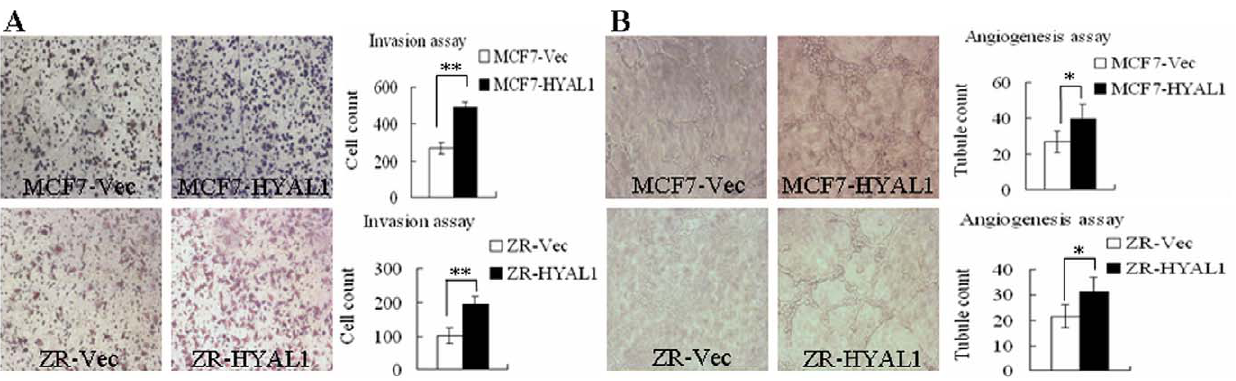
Figure 6. Upregulation of HYAL1 in breast cancer cells promoted cell invasion and angiogenic capability in vitro. Invasion assays (A) were performed using ECM gel-coated transwell culture chambers. 48 h after seeding for both MCF7 and ZR-75-30, the number of invasive cells was increased in pcDNA3.1-HYAL1 transfectants ( p , 0.01). Angiogenesis assay (B) for CRL-1730 cells formed branch-like or net-like structures through co- culture with MCF7 and ZR-75-30 cells. After 96 h co-culture, the number of vessels developed by CRL-1730 cells was enhanced in pcDNA3.1-HYAL1 transfectants ( p , 0.05), (original magnification 6 100).